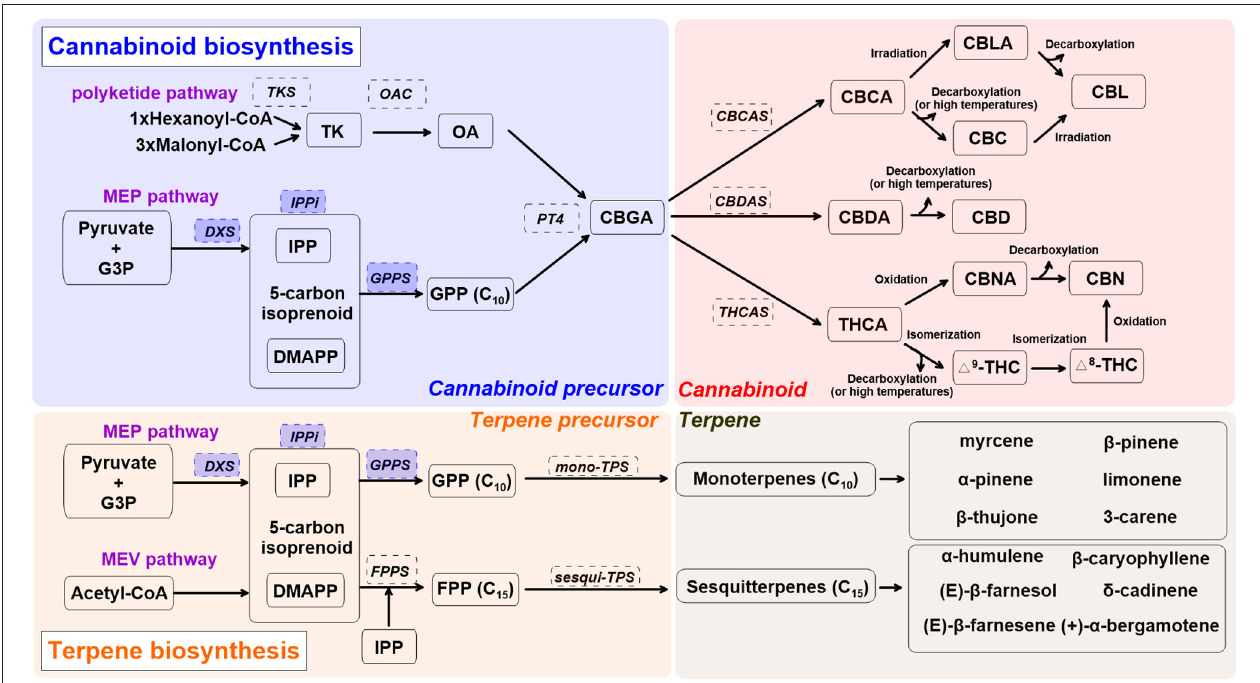
FIGURE 1 | A simplified overview of cannabinoid and terpene biosynthesis pathways in cannabis ( Cannabis sativa L.), derived from recent reviews (Hazekamp, 2007; Degenhardt et al., 2017; Sirikantaramas and Taura, 2017; Jin et al., 2019 ). Enzymes are in dashed line box. Enzymes in shaded blue boxes are upregulated by UV radiation and blue light in Lamiaceae. Cannabis precursor (shade blue): CBDA, cannabidiolic acid; DMAPP, dimethylallyl pyrophosphate; G3P, glyceraldehyde 3-phosphate; GPP, geranyl pyrophosphate; GPPS, geranyl pyrophosphate synthase; MEP, methylerythritol phosphate; PT4, geranylpyrophosphate: olivetolate geranyltransferase 4; IPP, isopentenyl diphosphate; IPPi, isopentenyl-diphosphate delta-isomerase; OA, olivetolic acid; OAC, olivetolic acid cyclase; TK, tetraketide; TKS, tetraketide synthase. Cannabinoid (shade red): CBC, cannabichromene; CBCA, cannabichromentic acid; CBCAS, cannabichromentic acid synthase; CBDAS, cannabidiolic acid synthase; CBD, cannabidiol; CBG, cannabigerol; CBGA, cannabigerolic acid; CBL, cannabicyclol; CBLA, cannabicyclolic acid; CBN, cannabinol; CBNA: cannabinolic acid; 1 8 -THC, 1 8 -tetrahydrocannabinol; 1 9 -THC (or THC), 1 9 -tetrahydrocannabinol; THCA, tetrahydrocannabinolic acid. Terpene precursor (shade orange): FPP, farnesyl diphosphate; FPPS, farnesyl diphosphate synthase; MEV, mevalonate; TPS, terpene